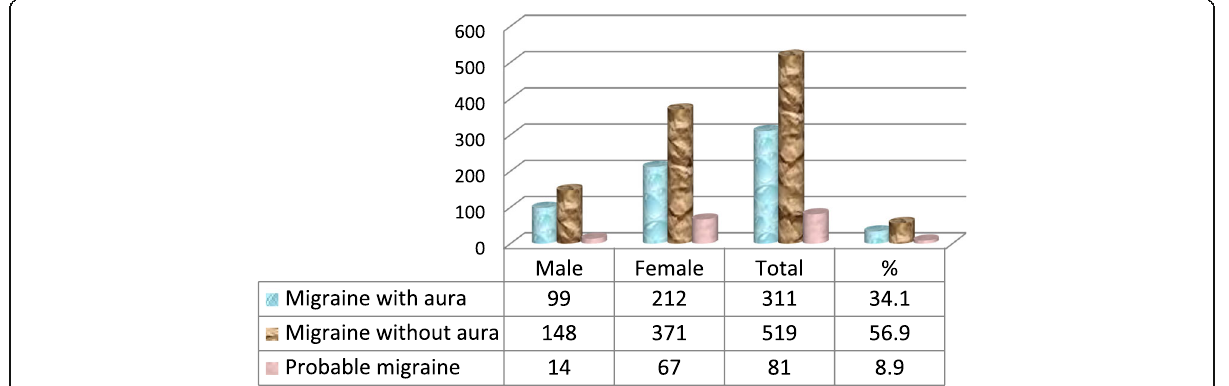
Fig. 2 Frequency of migraine subtypes among the studied population